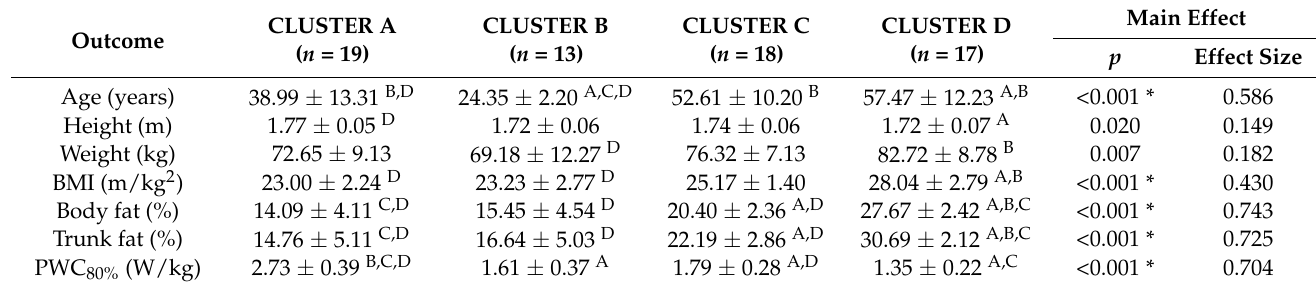
Table 2. Descriptive characteristics of the four cluster